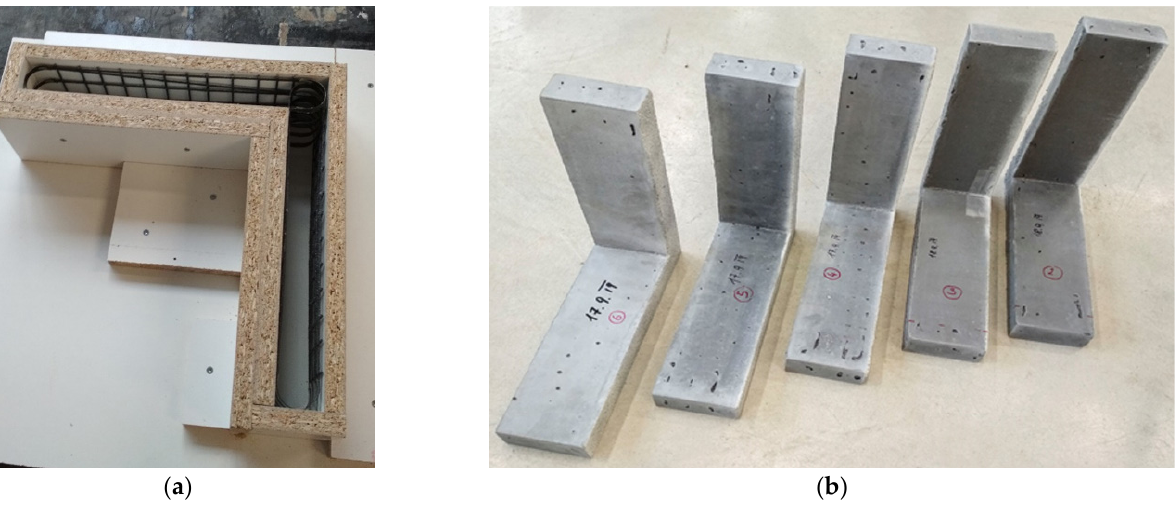
Figure 11. Formwork with installed reinforcement ( a ) and finished specimens ( b ).